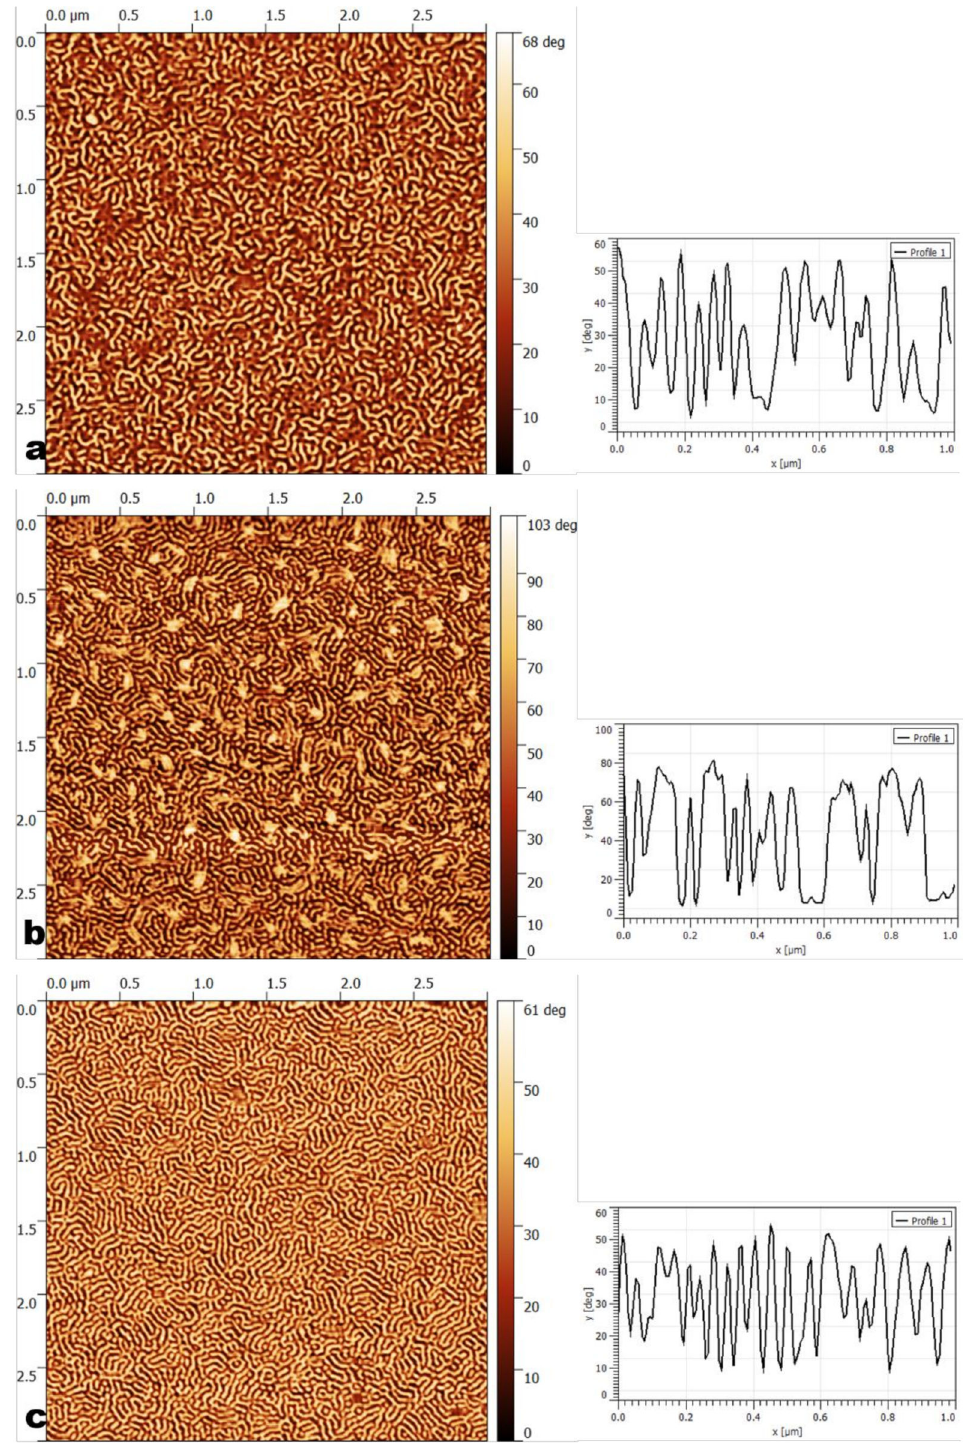
Figure 1. Atomic force microscopy (AFM) phase images (3 µ m × 3 µ m) and corresponding cross-sections (1 µ m × 1 µ m) of worm-like type morphologies: ( a ) worm-like (3 wt% poly(styrene-b-ethylene)/poly(propylene-b-styrene) (SEPS) casted from toluene annealed at 100 ◦ C); ( b ) worm-like with crystals (1 wt% SEPS casted from toluene annealed at 60 ◦ C); ( c ) worm-like with perpendicular cylinders (1 wt% SEPS casted from toluene annealed at room temperature